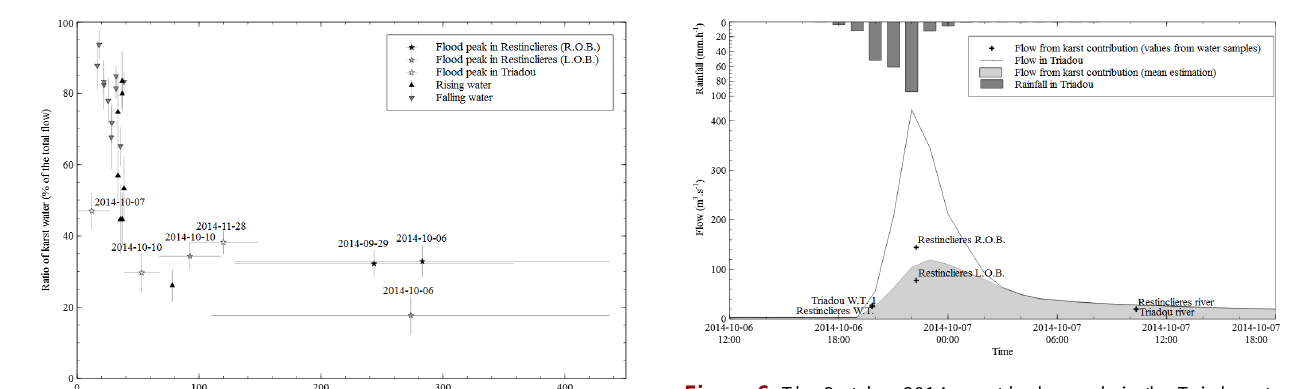
Figure 6. The October 2014 event hydrograph in the Triadou sta- tion with the estimated karst contribution (light grey